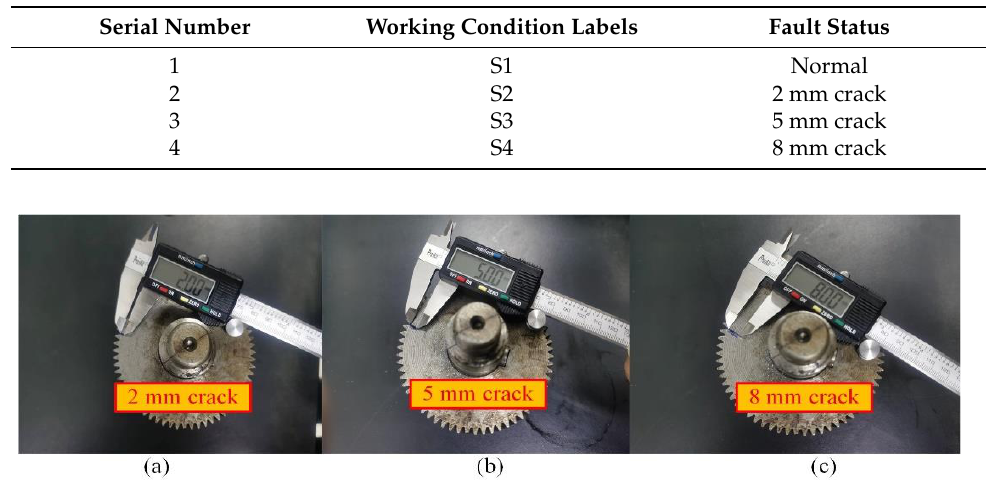
Figure 9. Fault preset states: ( a ) 2 mm crack, ( b ) 5 mm crack, ( c ) 8 mm crack.